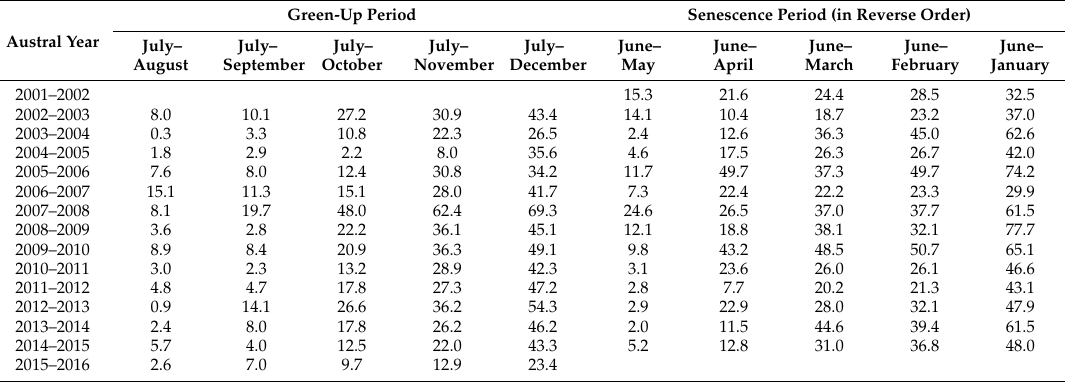
Table 1. Rainfall data of five meteorological stations in the study area (Rustenburg, Marbel Hall Moosriver, Lephalale, Bloemhof and Escelsior-benchmark), showing mean (mm) rainfall for the green-up and senescence periods of the vegetated